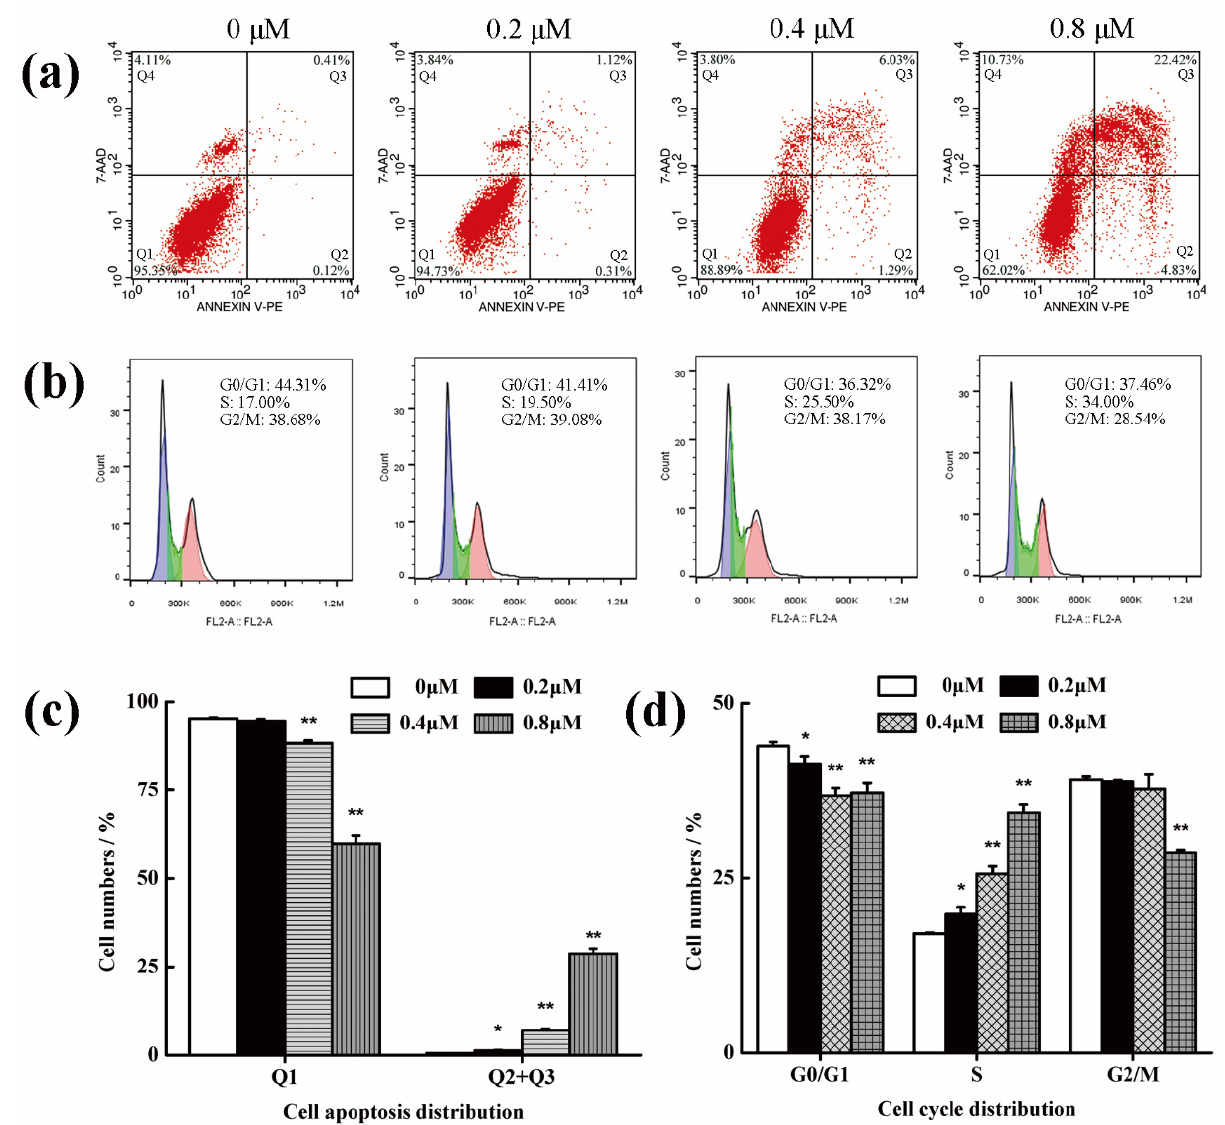
Figure 3. Effects of complex 4b on cell cycle and apoptosis of MCF-7 cells. ( a ) Apoptotic effect of 4b on MCF-7 cell line after treatment for 24 h. Q1, Q2, Q3, and Q4 respectively represent live cells, the earlier apoptotic cells, the late apoptotic cells, and cells damaged during the procedure. ( b ) Flow cytometric analysis indicated that 4b changed MCF-7 cell cycle distribution at 24 h. ( c ) The 4b increased apoptotic cell numbers. ( d ) 4b arrested cell cycle S phase of MCF-7 cells. Error bar show the SD, “*” p < 0.05, “**” p < 0.01, compared with the control cells at 24